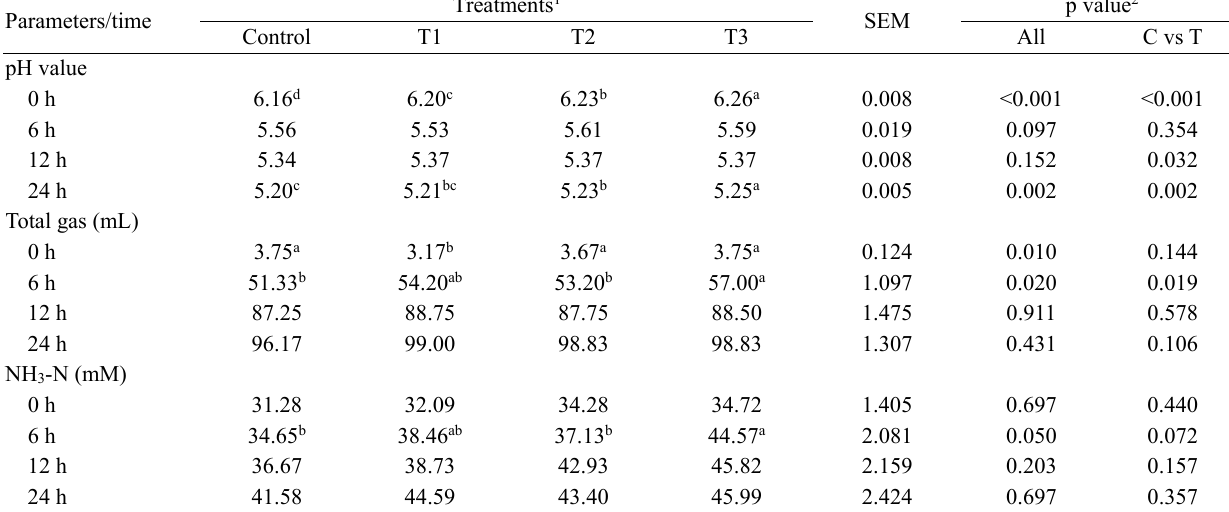
Table 2. pH, total gas and ammonia nitrogen (NH 3 -N) production from in vitro rumen fermentation by the addition of lysozyme Parameters/time